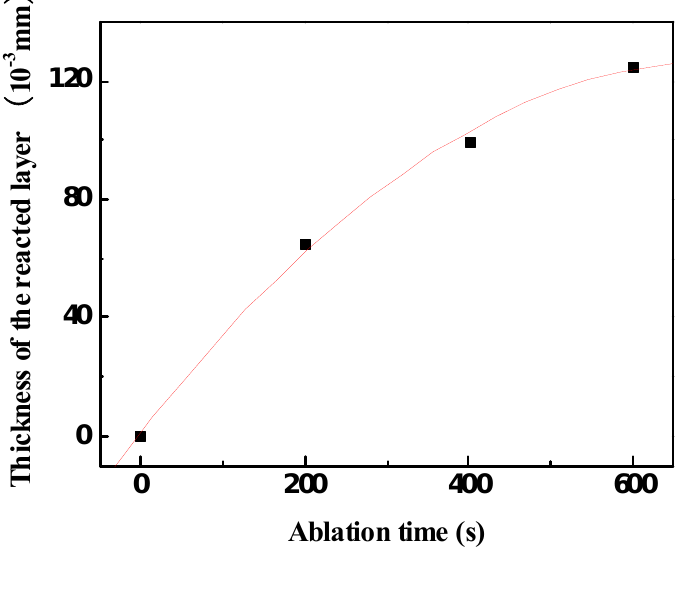
Figure 10. Thickness of the reacted layer vs. ablation time obtained under condition